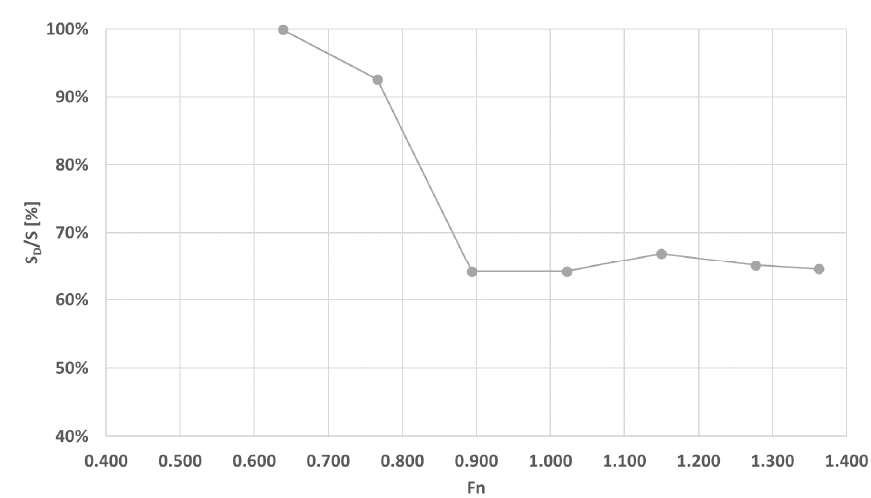
Figure 13. Wetted surface ratio–Dynamic/Static surface.